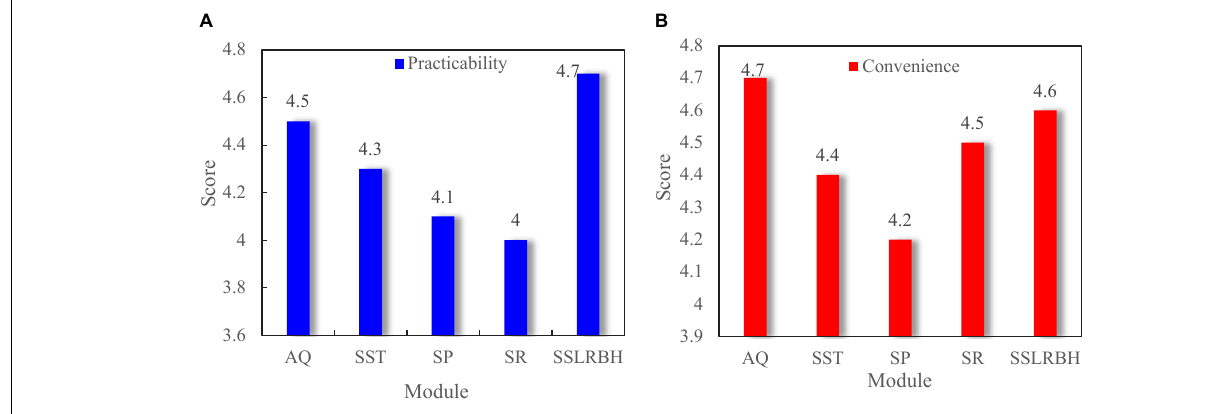
FIGURE 6 | Integration score of financial self-service terminal. (A) Practicability. (B) Convenience.